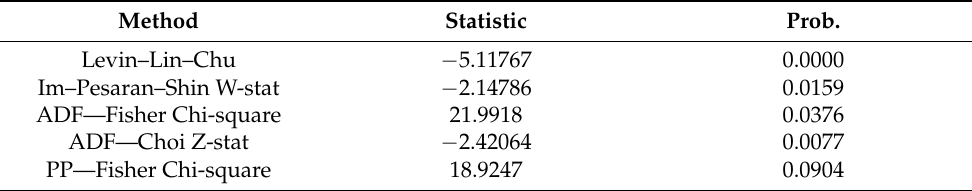
Table 3. Unit root test.